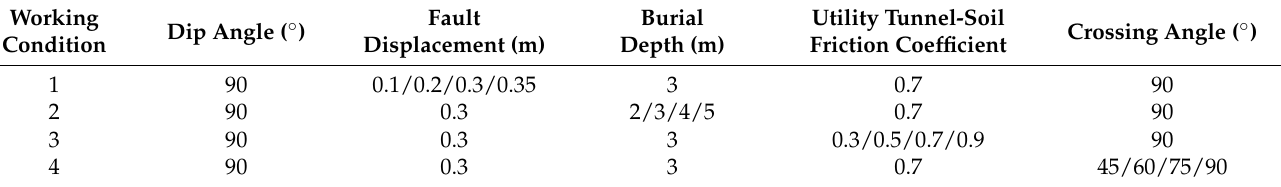
Table 3. Working conditions of the influencing factors analysis.